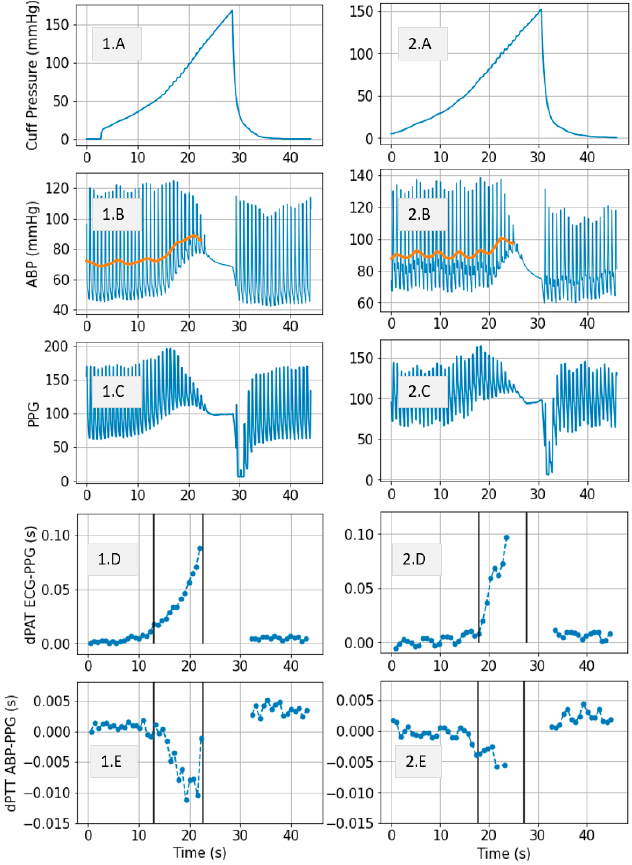
Figure 4. Example signals Patient 1 ( left ) and Patient 2 ( right ). Highly dynamic and patient specific effects are occurring in the distal arm as result of the cuff inflation. The plots show: ( A ) Cuff pressure; ( B ) Blue: Arterial pressure (ABP) measured invasively downstream form the cuff at radial site, Orange: MAP; ( C ) PPG signal measured at finger site downstream from the cuff; ( D ) ∆ PAT ECG − PPG ( Cuf f P ) ; ( E ) ∆ PTT ABP − PPG ( Cuf f P ) .